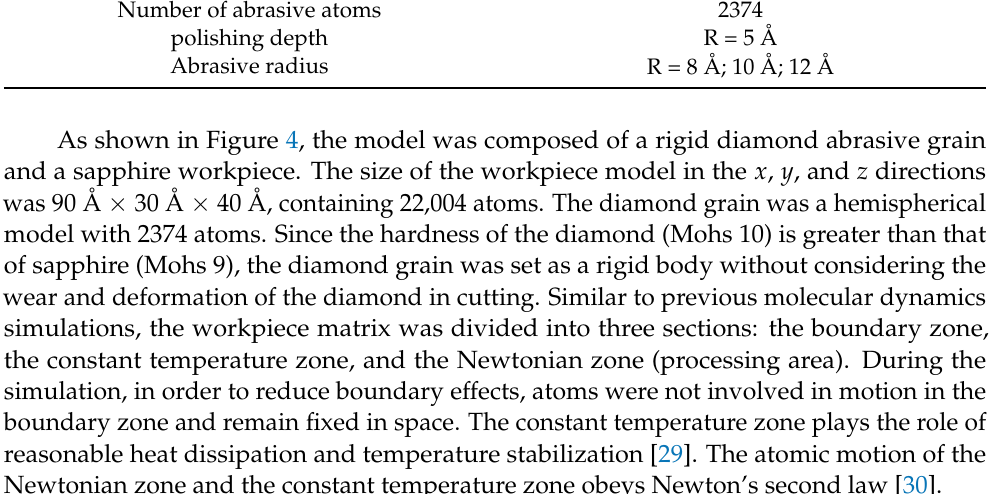
Table 1. Simulation model parameters of different abrasive particle radii.